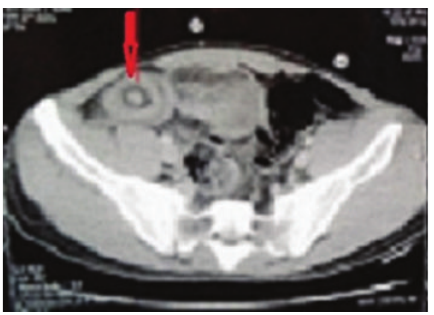
Figure 5: Histopathological features typical of a benign submucosal lipoma (H&E staining with magnification of